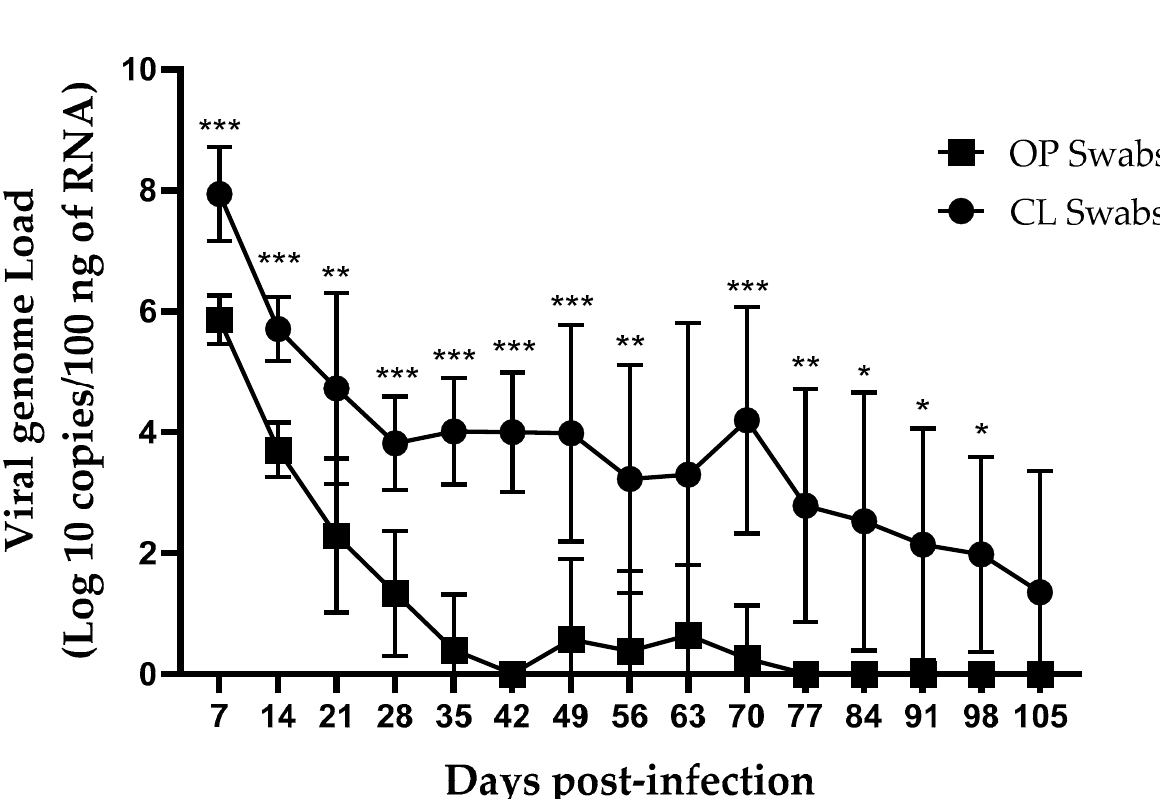
Figure 2. IBV genome loads in weekly collected OP and CL swabs following infection at 1-day of age. The average starting IBV copies was quantified per 100 ng of the extracted RNA and differences between OP and CL swabs were compared using Mixed-effects model followed by Sidak’s multiple comparisons test, and the error bars represent the SD. Statistical significance: * p < 0.05, ** p < 0.01, *** p < 0.001.